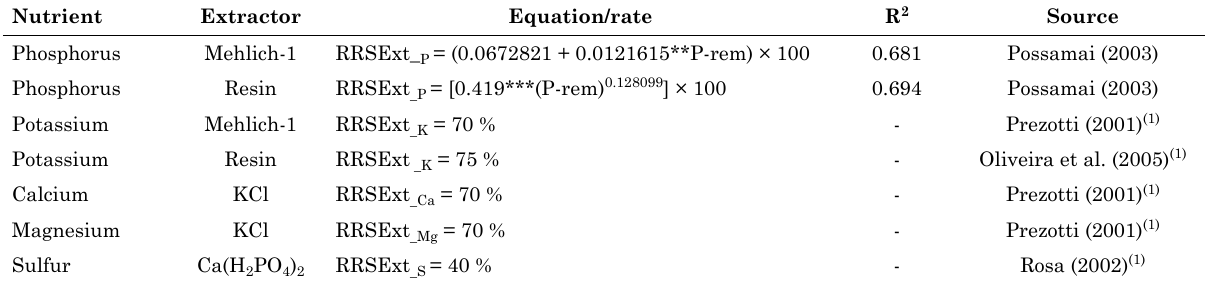
Table 3. Recovery rate of the nutrient by extractors adopted by Ferticalc-melon Nutrient Extractor Equation/rate